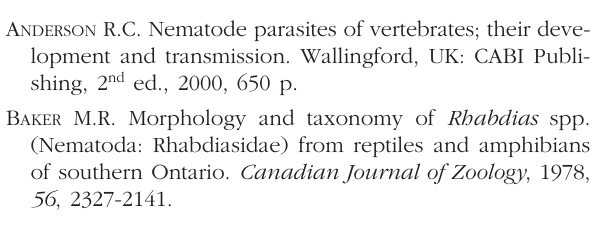
Grey: young/small specimens. Table VI. – Body length and size of buccal capsule in youn/small (grey background) and main from African and Malagasy